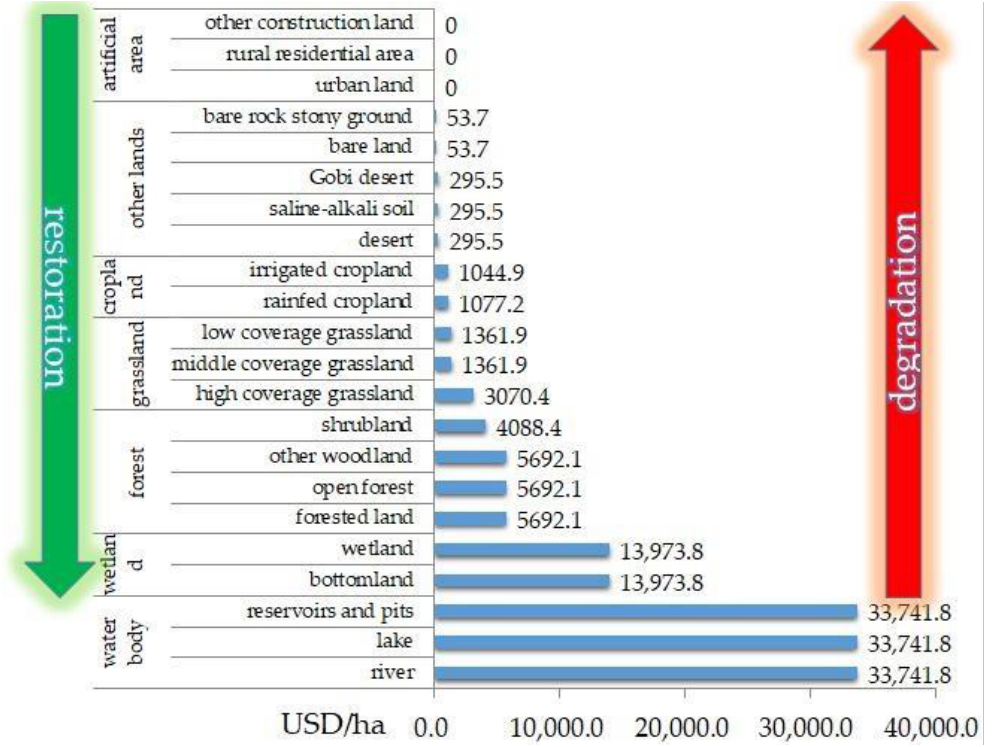
Figure 3. Criteria of modified LUCC conversion based on ESV.